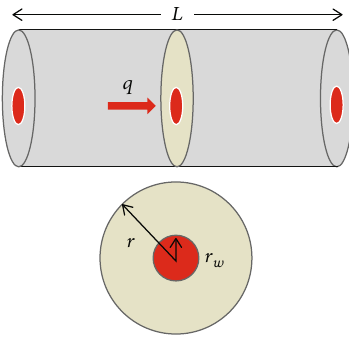
Figure 4: Sketch map of thermal conduction at cross-section of the horizontal well